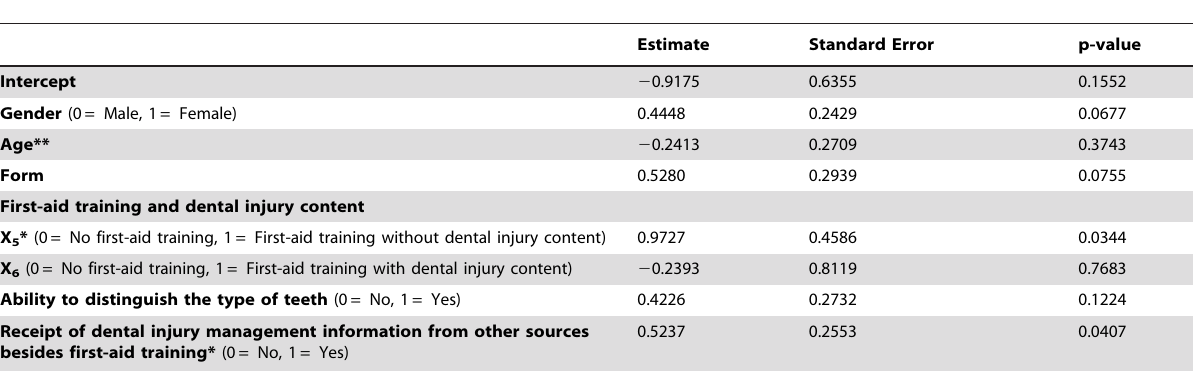
Table 6. Relationship between total score and the independent variables.